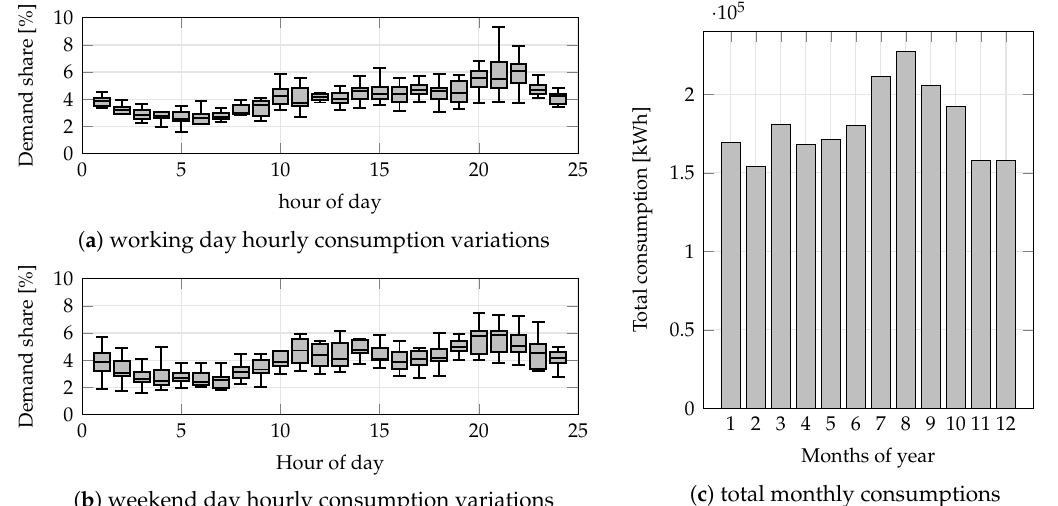
Figure 5. Monthly seasonal variations in hourly electric energy consumption share for working days ( a ), weekend days ( b ) and total monthly electric energy consumptions ( c ) based on data provided by Fenie Energia.